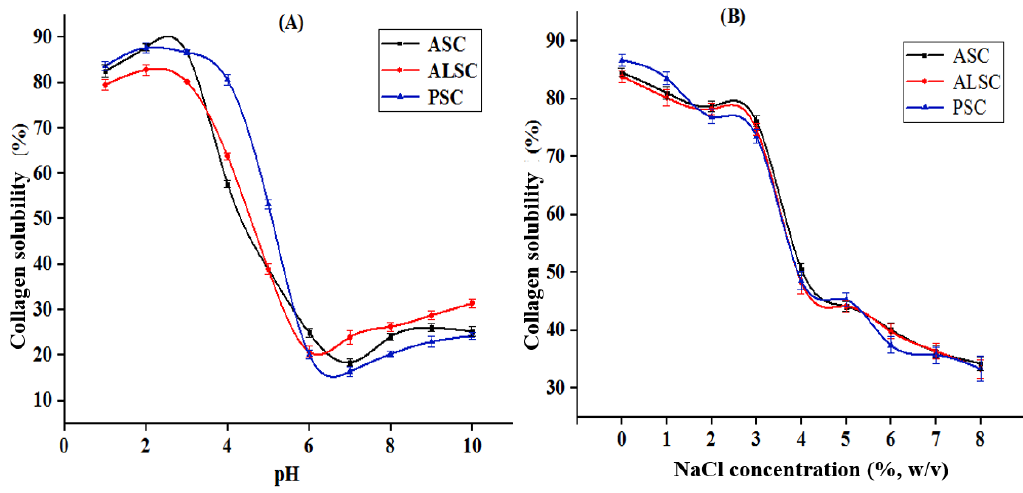
Figure 5. Effects of pH (A) and NaCl (B) on the solubility of ASC, ALSC, and PSC.